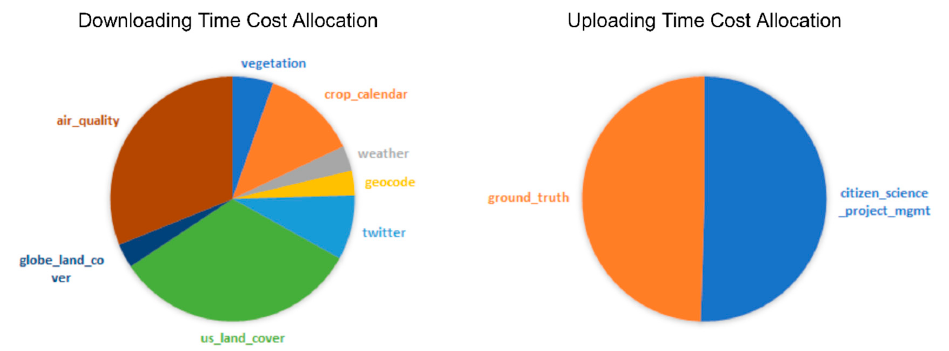
Figure 8. GeoFairy2 Time Cost Pies.